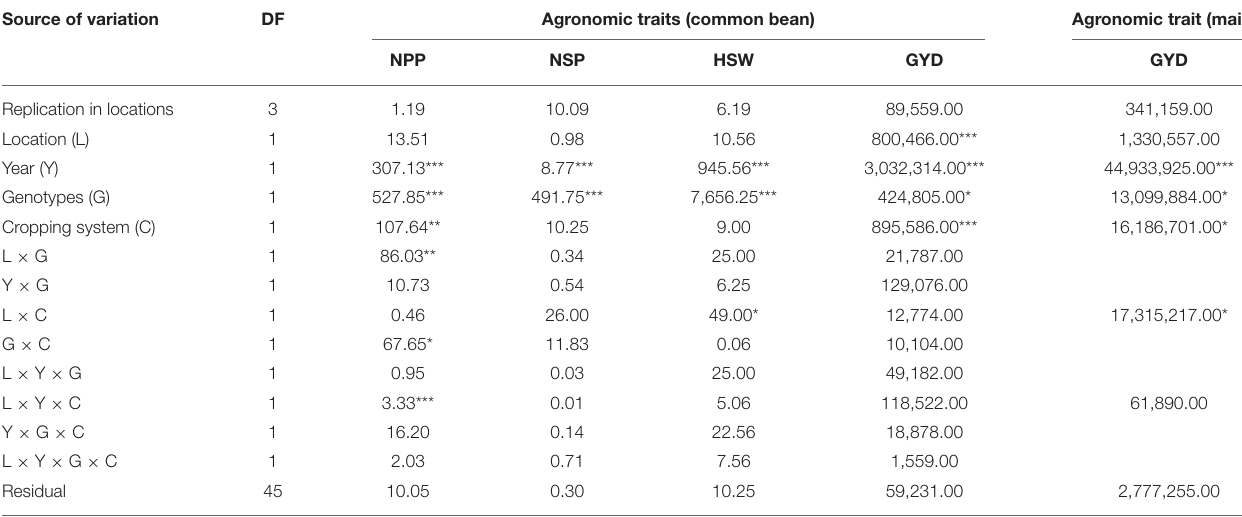
TABLE 4 | Combined analysis of variance with mean squares and a significant test for agronomic traits of two common bean genotypes when cultivated as a sole crop or intercropped with a maize variety at Chitedze and Linthipe in 2018/2019 and 2019/2020 cropping season. Source of variation DF